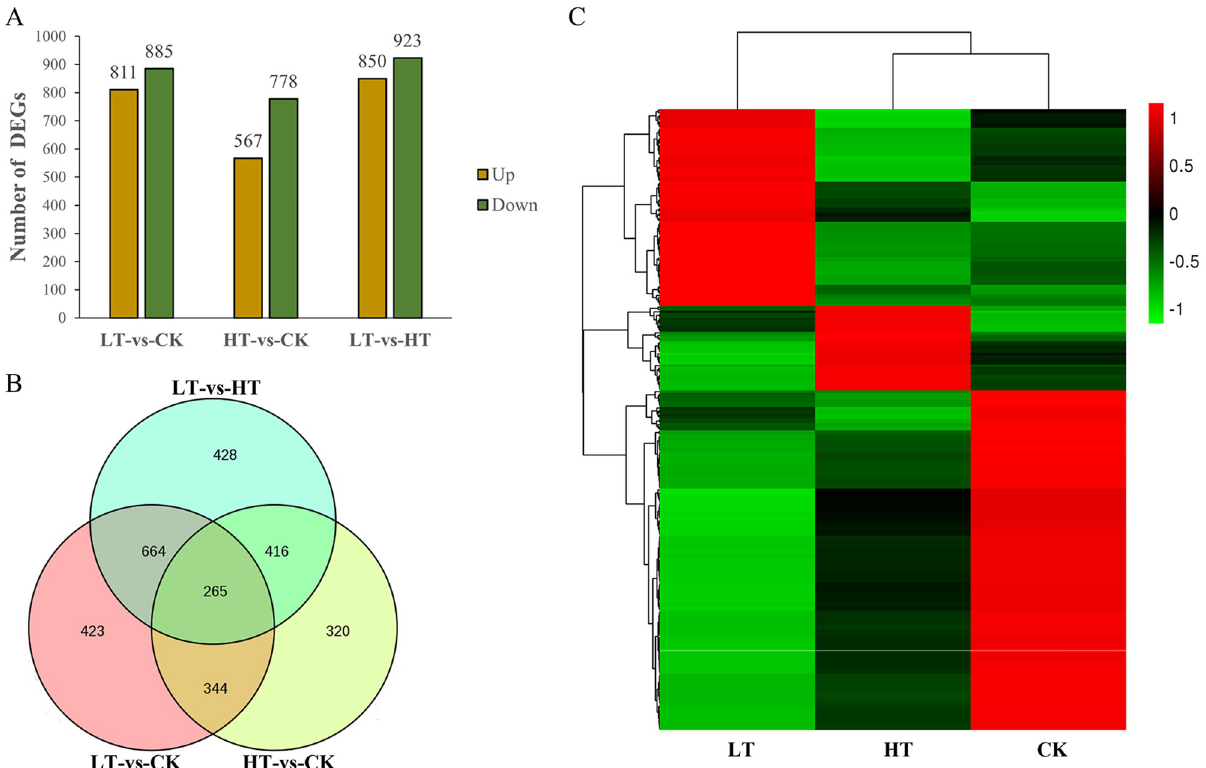
Fig 3. Analysis of the DEGs in A . oryzae incubated at different temperatures. (A) The distribution of DEGs between each pair of compared transcriptomes. (B) Venn diagram of DEGs A . oryzae incubated at different temperatures. The Venn diagram was generated using Venny 2.1 software (https://bioinfogp.cnb.csic.es/tools/venny/index.html). (C) A heatmap of 265 co-expressed DEGs in three temperature treatments. Red and green represent the upregulated and downregulated genes, respectively. The heatmap was generated using HemI_windows_1_0 software (http://hemi. biocuckoo.org/down.php). LT, samples incubated at 22˚C. CK, samples incubated at 30˚C. HT, samples incubated at 42˚C.